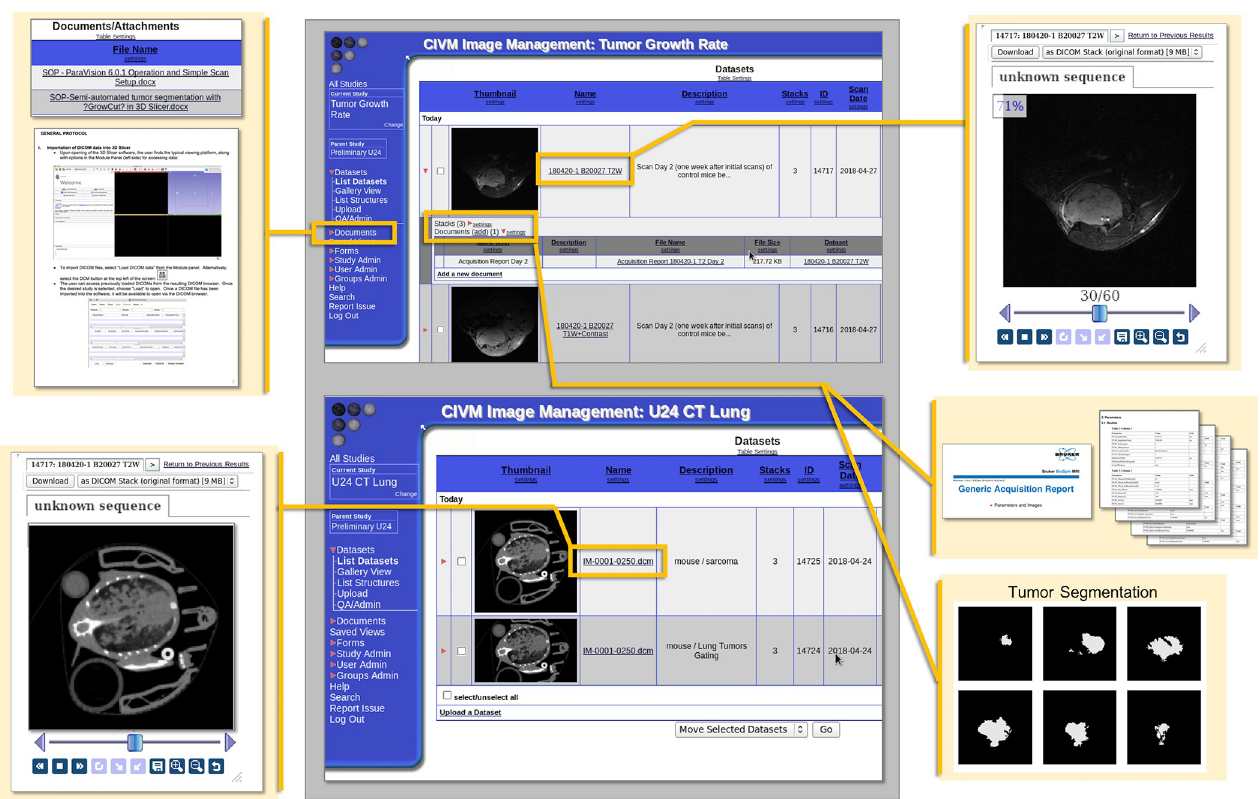
Fig 10. Demonstration of the VoxPort interface for image data sharing. Images of VoxPort demonstrating archives of multiple forms of imaging data, including images from multiple modalities, protocol documentation and standard operating procedures, scan acquisition information, and segmentation stacks which correspond to archived images. The image gallery provides a thumbnail and metadata about the images. The user can choose to download a given image or stack or examine the data within the interface.